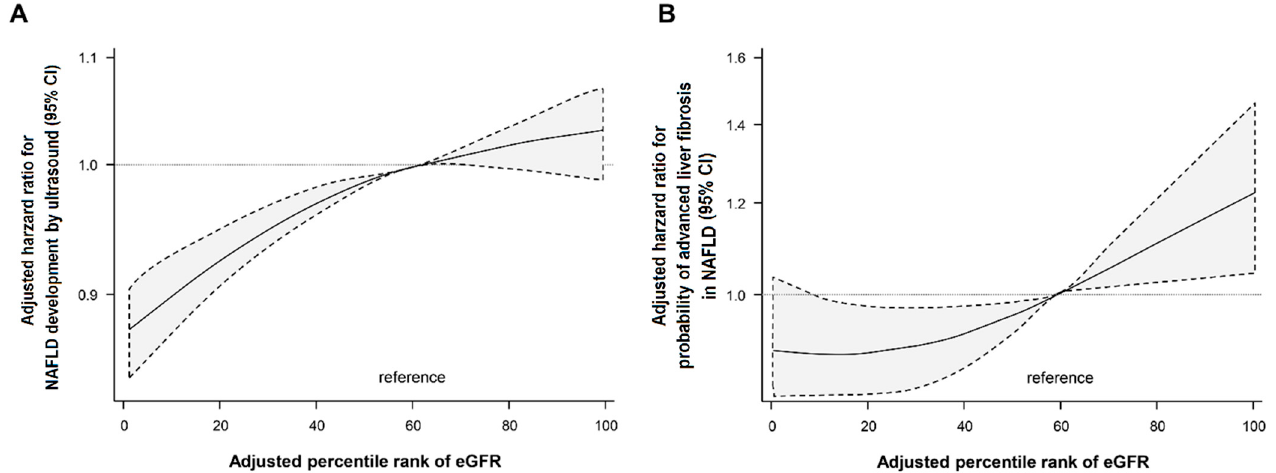
Figure 2. HR for the development of NAFLD ( A ) and advanced liver fibrosis of NAFLD based on NFS ( B ) according to baseline eGFR percentile. Adjusted for age, sex, muscle mass, BMI, smoking status, regular exercise, history of diabetes, dyslipidemia, hypertension, hs-CRP, and HOMA-IR. BMI: body mass index, eGFR: estimated glomerular filtration rate, GHF: glomerular hyperfiltration, HOMA-IR: homeostasis model assessment of insulin resistance, HR: hazard ratio, hs-CRP: high- sensitivity C-reactive protein, NAFLD: nonalcoholic fatty liver disease, NFS: NAFLD fibrosis score, Non-GHF: non-glomerular hyperfiltration.